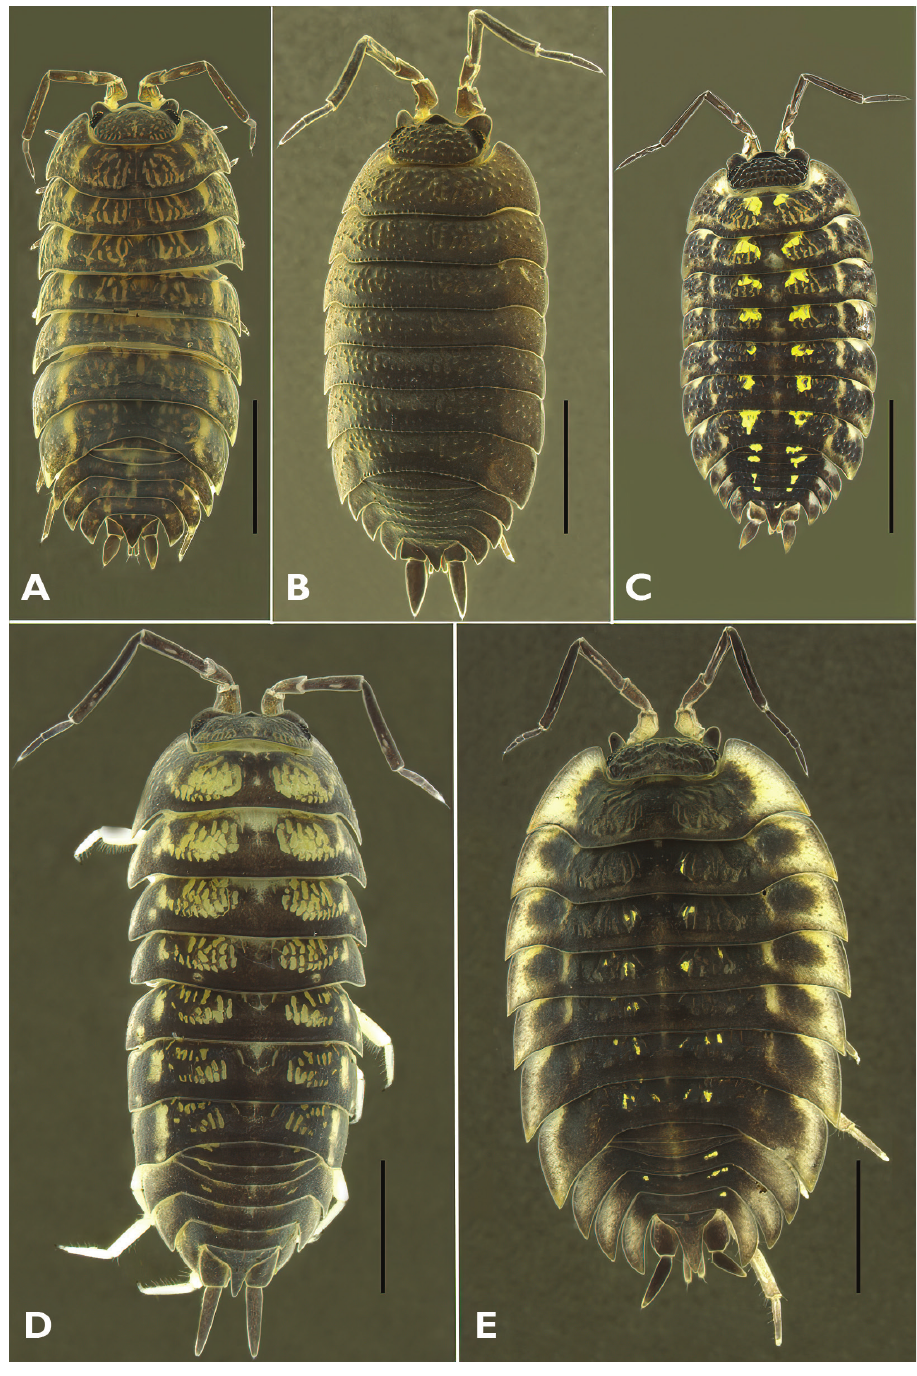
Figure 2. Habitus of Estonian Oniscidea species A Trachelipus rathkii B Porcellio scaber C Porcellio spini- cornis D Cylisticus convexus E Oniscus asellus . Scale bars: 2